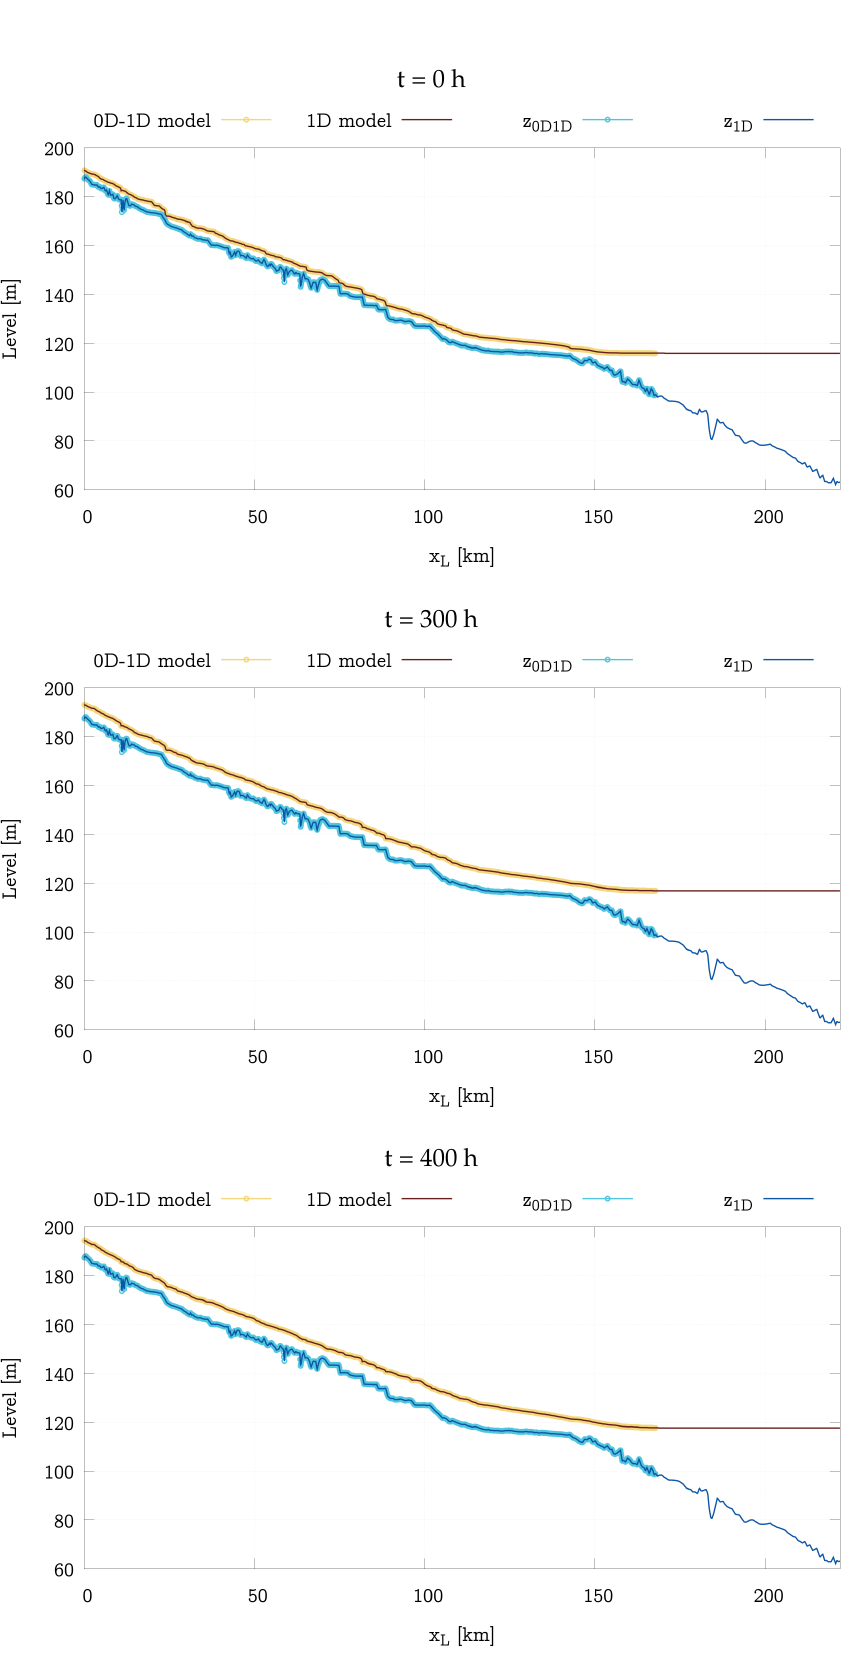
Figure 12. Longitudinal profile of bottom level, z , and water surface elevation (WSE) at different times computed with the 1D model and the coupled 1D-0D model for the 2015